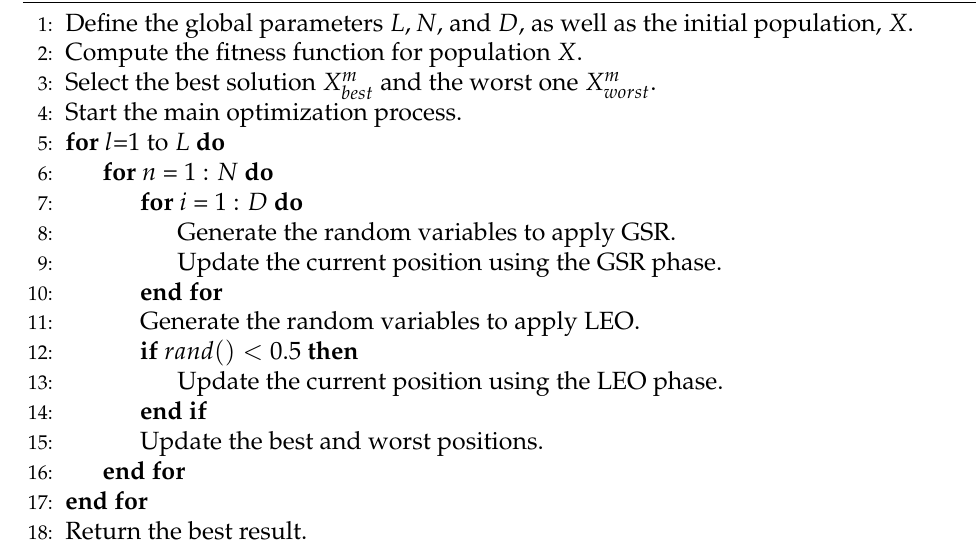
Algorithm 1 Gradient-based